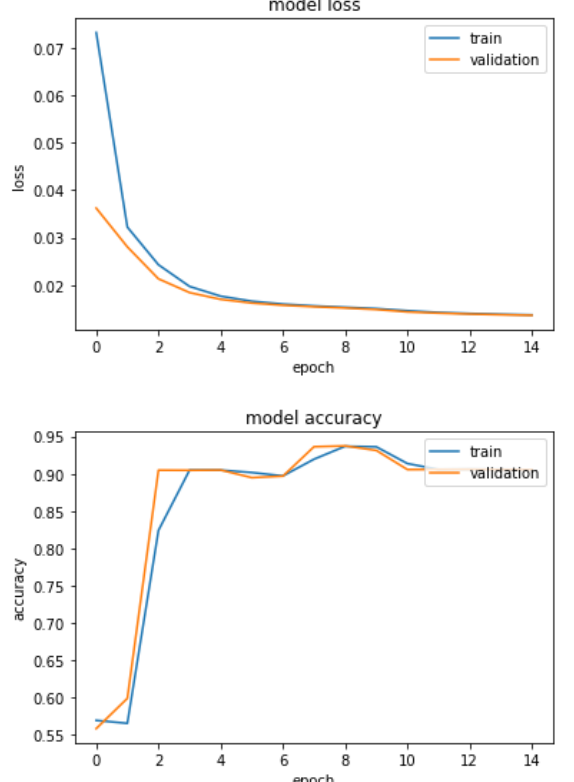
Figure 4. Variation curves of loss rate and accuracy with epoch for the autoencoder